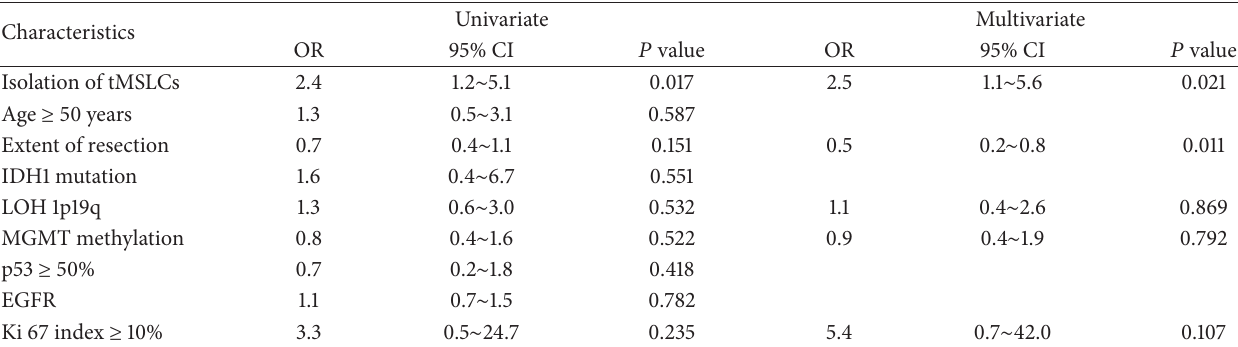
Table 2: Cox proportional hazard regression model of factors prognostic of overall survival in patients with